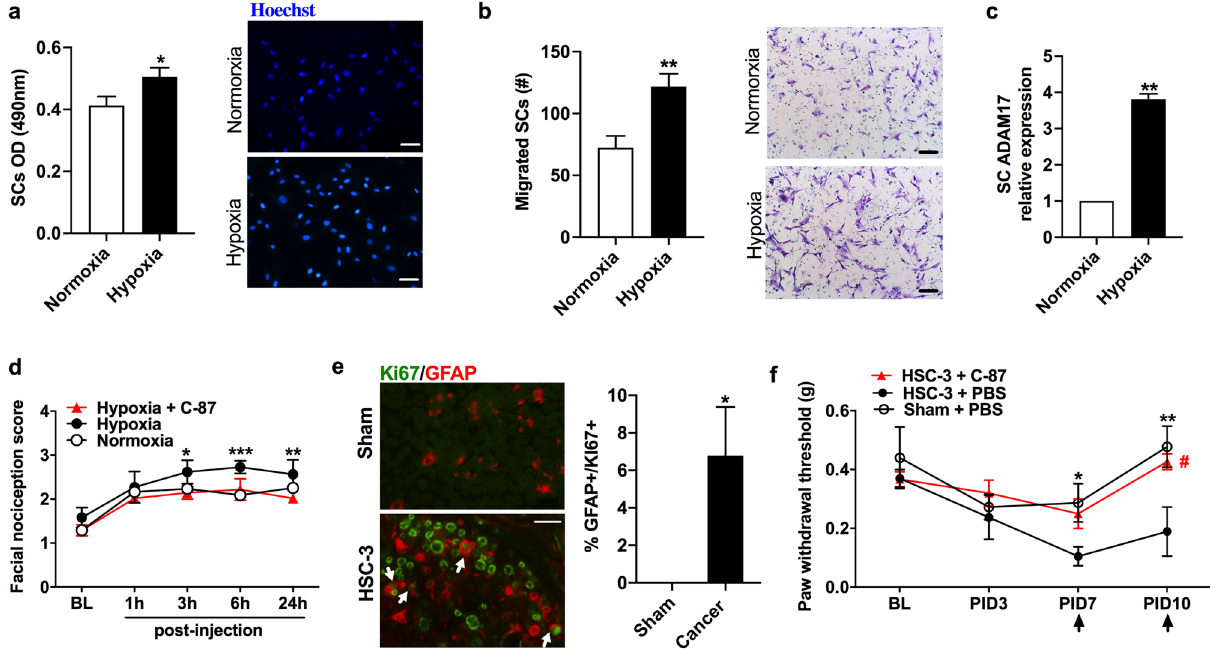
Figure 7. Activated Schwann cells induce nociceptive behaviors in mice. ( a ) Hypoxia increased Schwann cell proliferation compared to Schwann cells cultured under normoxic conditions. MTS assay. ( b ) Hypoxia increased Schwann cell migration towards 10% FBS compared to Schwann cells cultured under normoxic conditions. ( c ) Hypoxia significantly increased ADAM17 mRNA expression in Schwann cells compared to normoxia. ( a – c ) Student’s t test. ( d ) Facial nociception scores of mice at the baseline and at 1 h, 3 h, 6 h and 24 h following injection of supernatant from Schwann cells cultured under the following conditions: (1) normoxia, (2) hypoxia, and (3) hypoxia plus C-87 treatment. Mice who received hypoxic Schwann cell supernatant exhibited higher nociceptive scores compared to mice who received the normoxia supernatant or mice received hypoxia supernatant plus C-87 treatment. Two-way ANOVA. ( e ) Sciatic nerves with PNI exhibited increased Schwann cell proliferation (increased percentage of Ki-67 + /GFAP + cells) compared to nerve sections from the sham group. No Ki-67 positive cells were identified in the sham group. ( f ) Von Frey paw withdraw assay with the sciatic nerve PNI model. At day PID7 sham (PBS injection into the sciatic nerve) mice recovered from surgery/injection-induced pain whereas mice with tumor cells injected in the sciatic nerve continued to exhibit increased nociception. Paw withdrawal threshold was significantly lower in HSC-3 mice compared to sham mice at PID 7 and PID10. The SCC induced paw mechanical allodynia was reduced by C-87 treatment (arrows) at PID10 but not at PID7. Von Frey paw withdrawal assay was performed 1 h following C-87 injection. Images were taken using Nikon imaging software NIS-Elements F Ver4.60.00. Two-way ANOVA. * P < 0.05; ** P < 0.01; *** P <